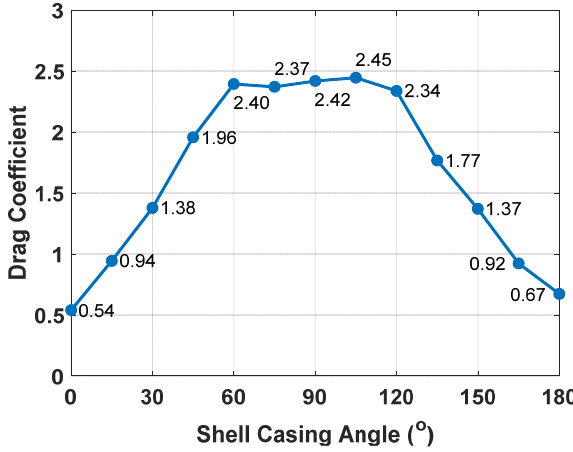
Figure 9. Drag coefficients at each shell casing’s AOA.